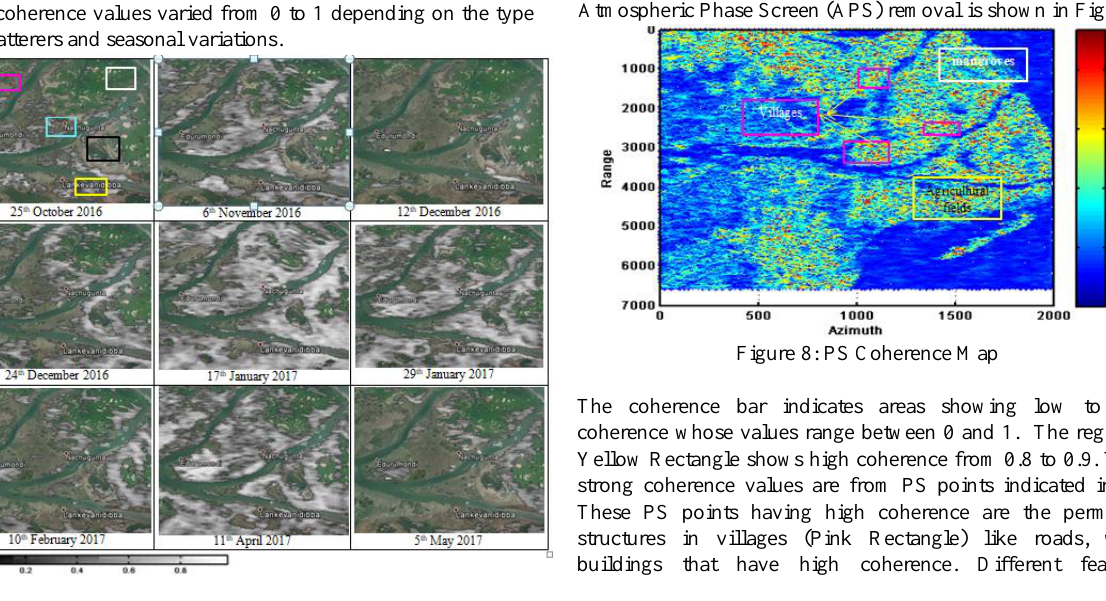
Figure 6: Amplitude stability index image of Krishna Delta